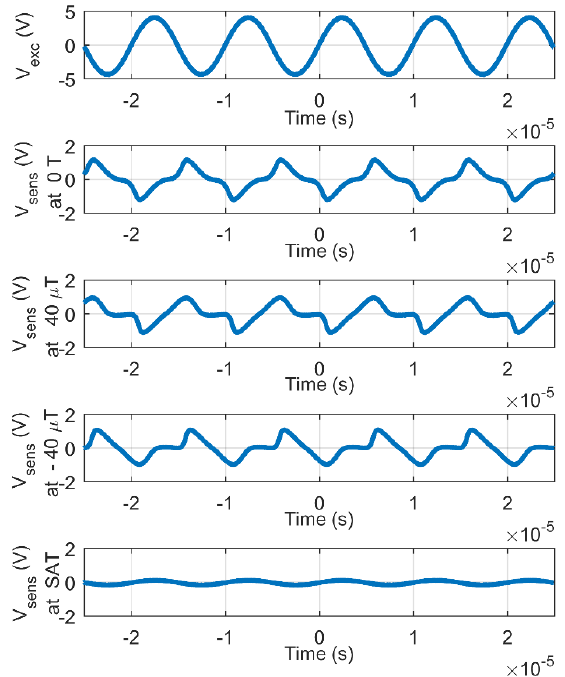
Figure 3. Waveforms of the fluxgate sensor with 700 mA p-p excitation current at 100 kHz: for the excitation coils (first signal) and for the sensing coil, respectively, at B = 0 T, B = +40 µT, B = −40 µT and at saturation.